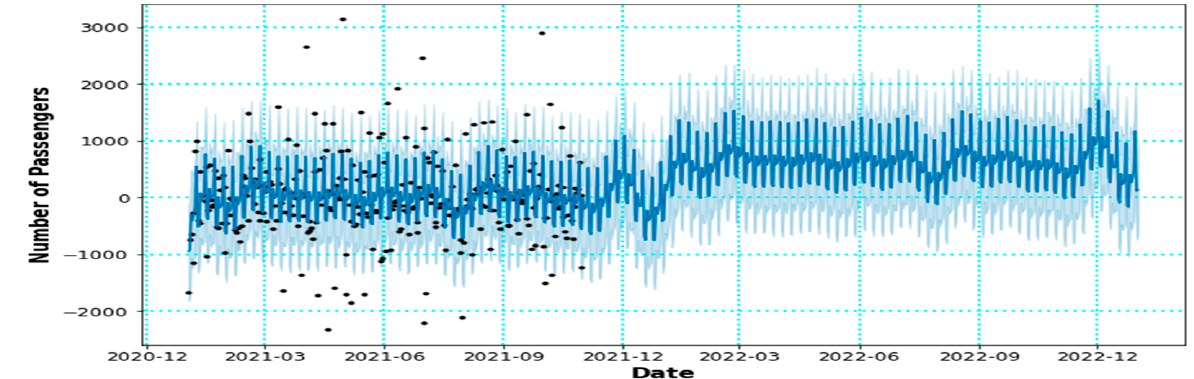
Figure 12. The plot of actual vs. prediction using the prophet model.